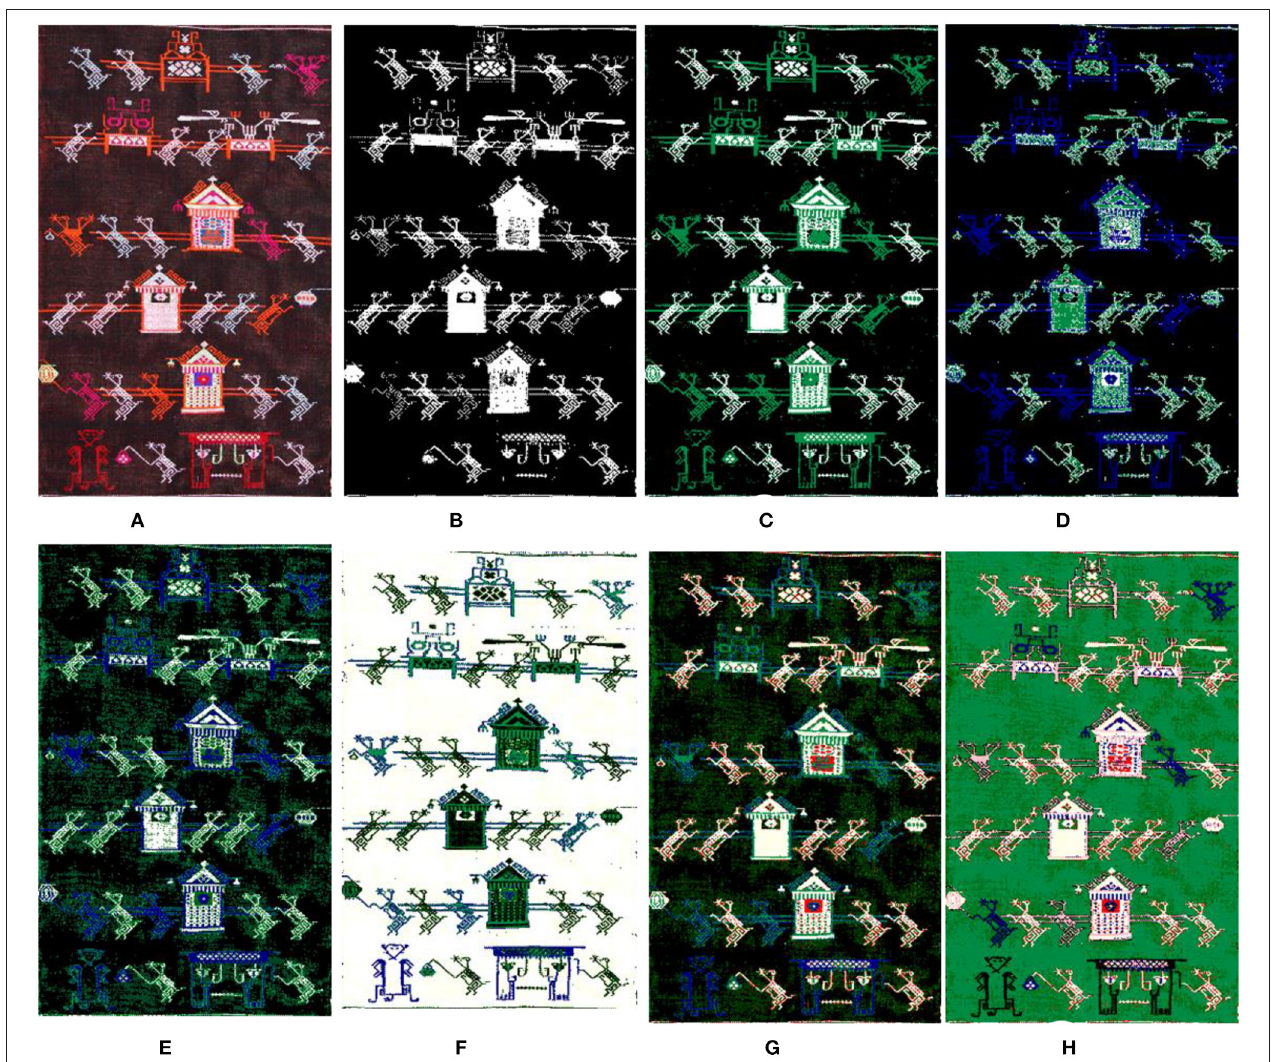
FIGURE 2 | The segmentation results by the GMM uses different K -values. (A) Original. (B) K = 2. (C) K = 3. (D) K = 4. (E) K = 5. (F) K = 6. (G) K = 7. (H) K =